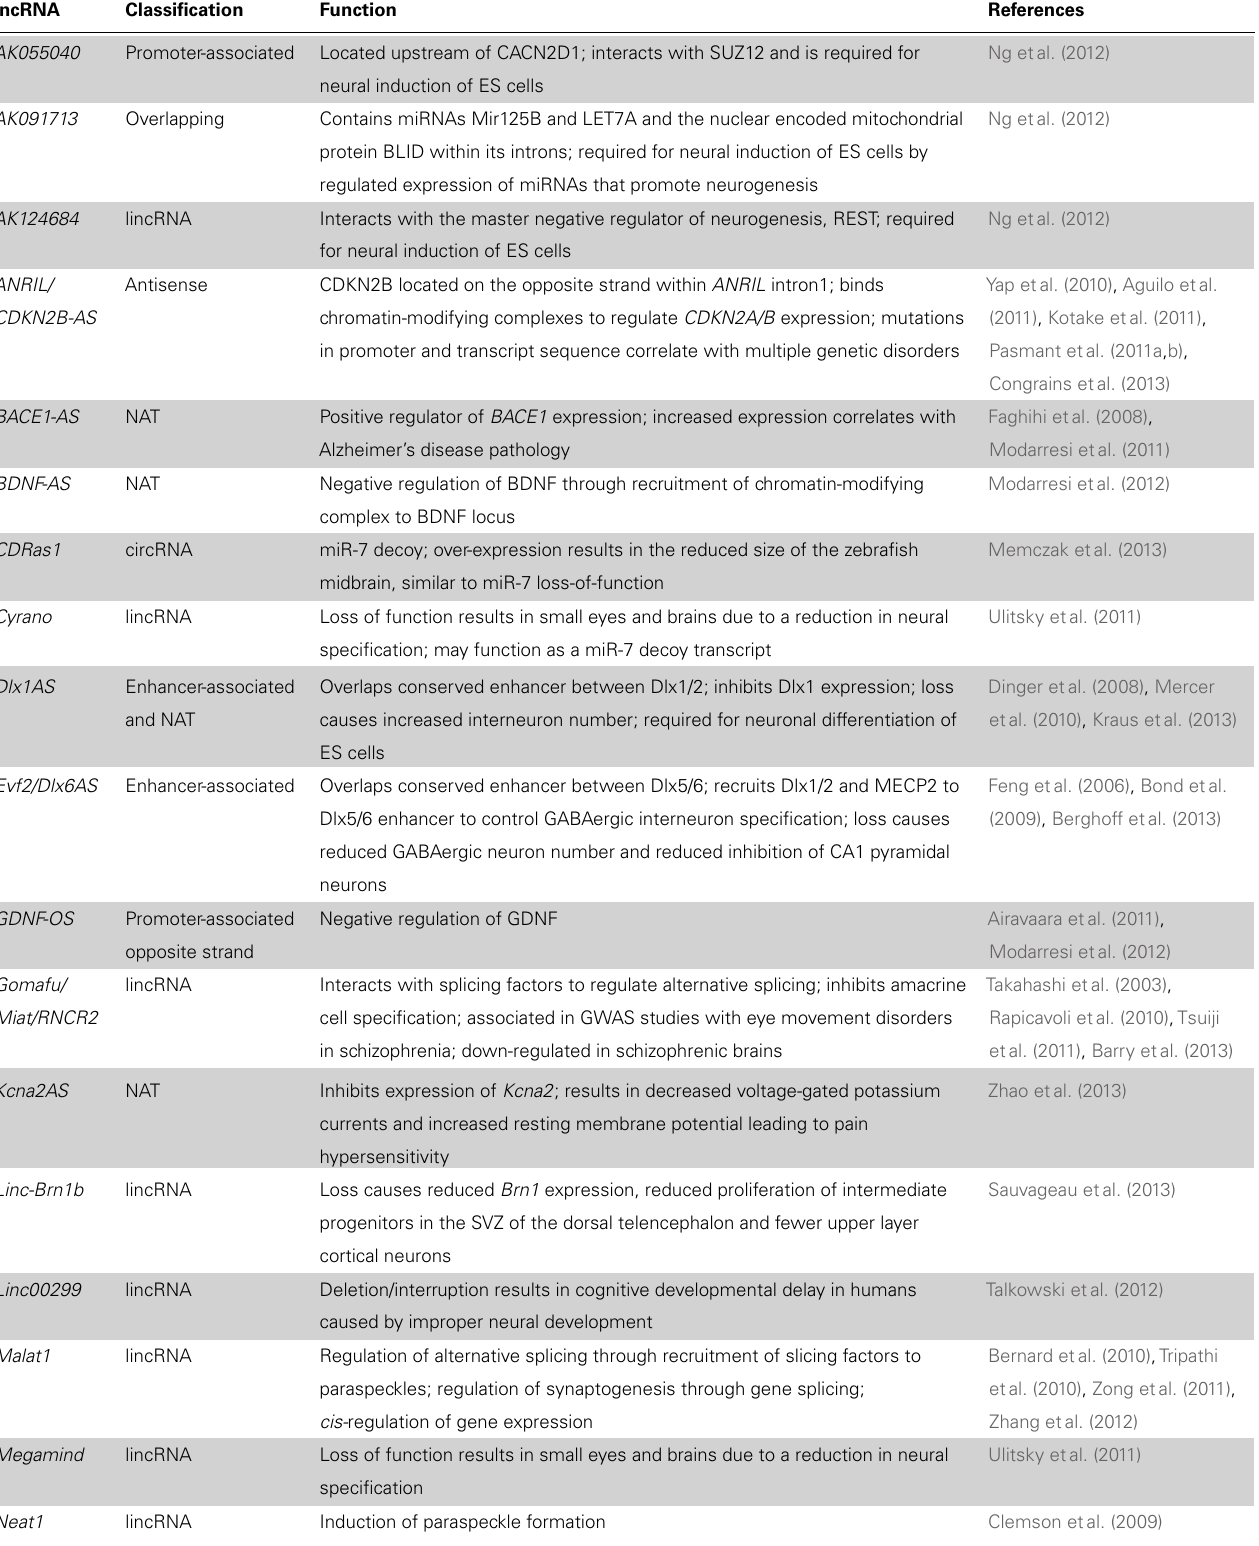
Table 1 | LncRNAs in neurodevelopment and neurodevelopmental disorders.